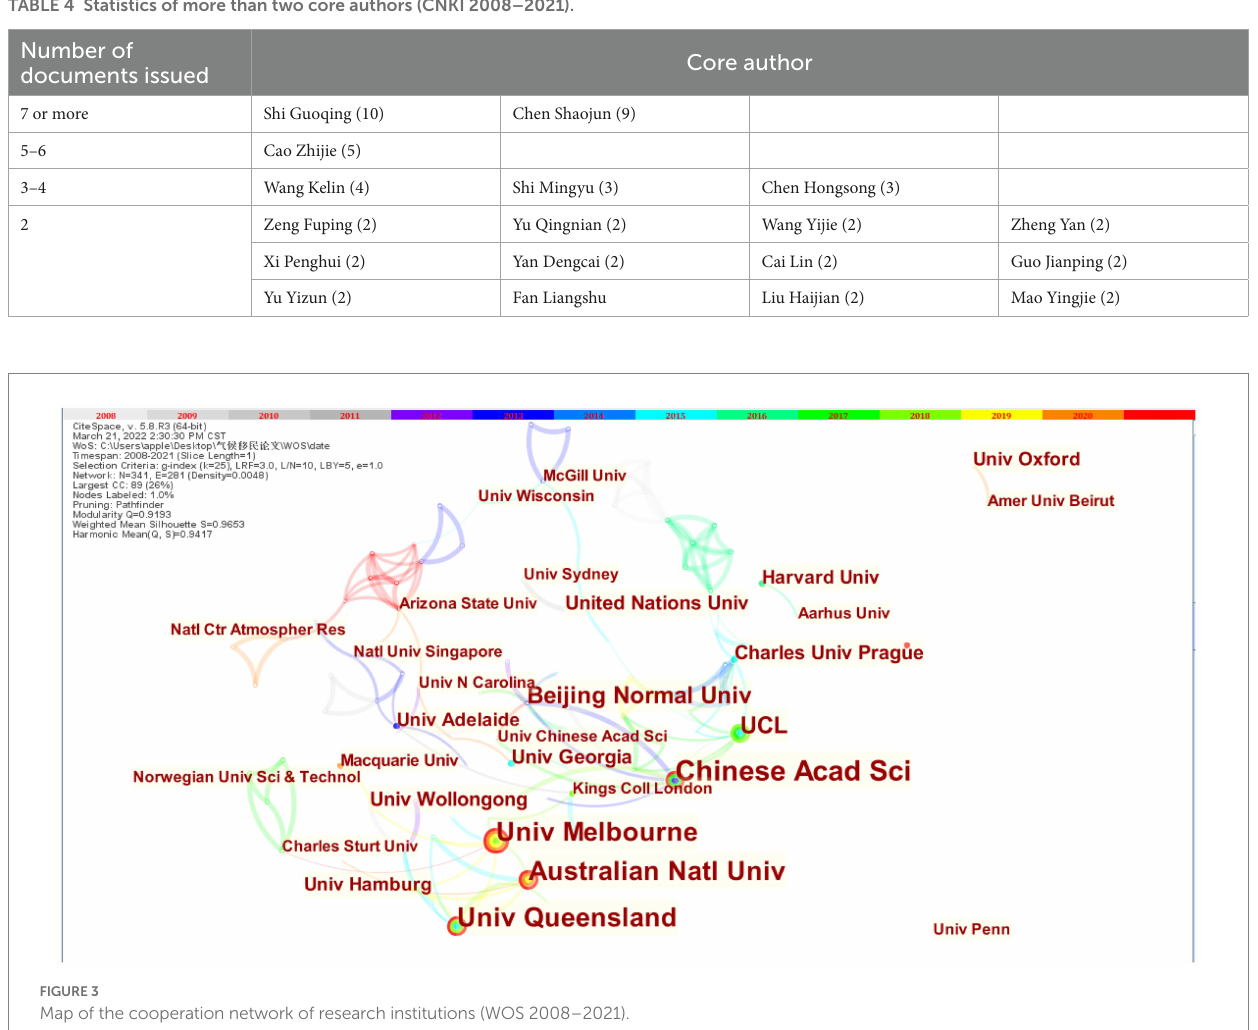
more representative the clustering label words are. The number of keywords in keyword clustering is greater than 10 indicating that the clustering is meaningful. According to the LLR algorithm, a total of 18 clusters are obtained. Since the number of keywords in cluster # 16 and cluster # 17 is only 8 which is less than 10 they are eliminated without analysis so that we can obtain a total of 16 effective clusters (Table 6). The number of clusters represents the total number of keywords contained in the cluster. The degree of clustering represents the similarity between the members of the cluster. The larger the number the more similar it is. For example for cluster # 0, the number of clusters is 48 indicating 48 keywords and the compactness is 0.931 indicating substantial similarity among cluster members. The